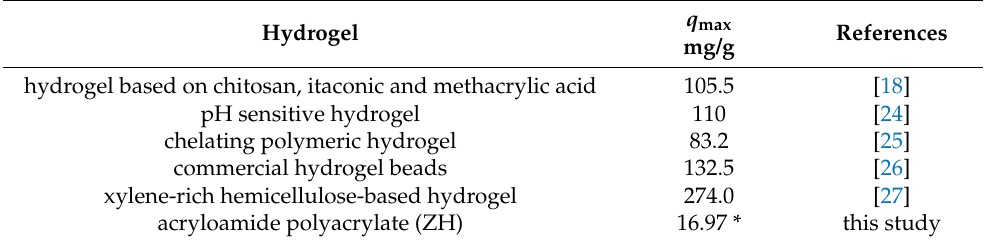
Table 3. The comparison of maximum adsorption capacity of different hydrogels for Zn(II) ions. Hydrogel